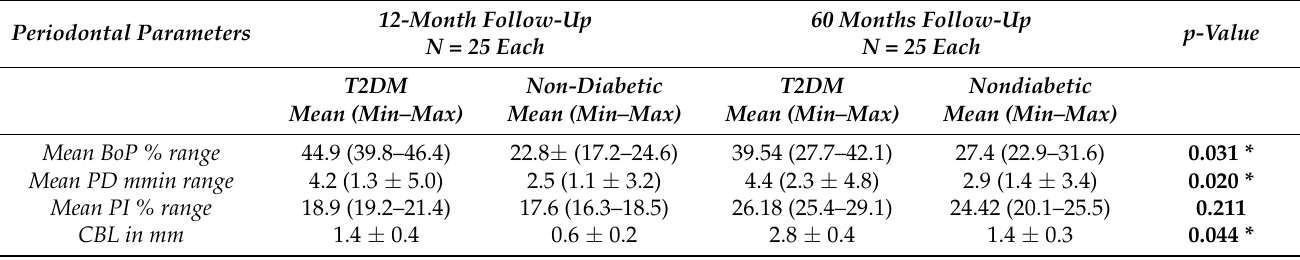
Table 2. Periodontal parameters and radiographic peri-implant indices at 12 months and 60 months around STIs in patients with diabetes and non-diabetes using the Kruskal–Wallis